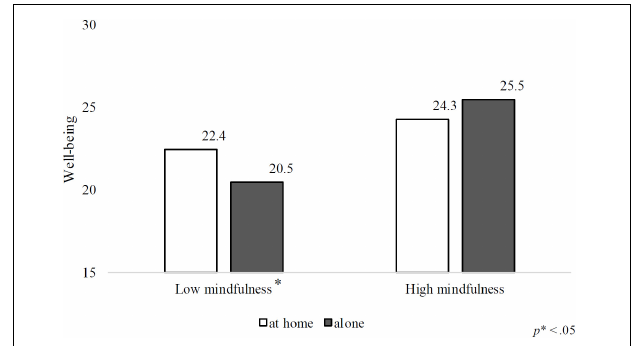
FIGURE 1 | The interaction effect of living condition and